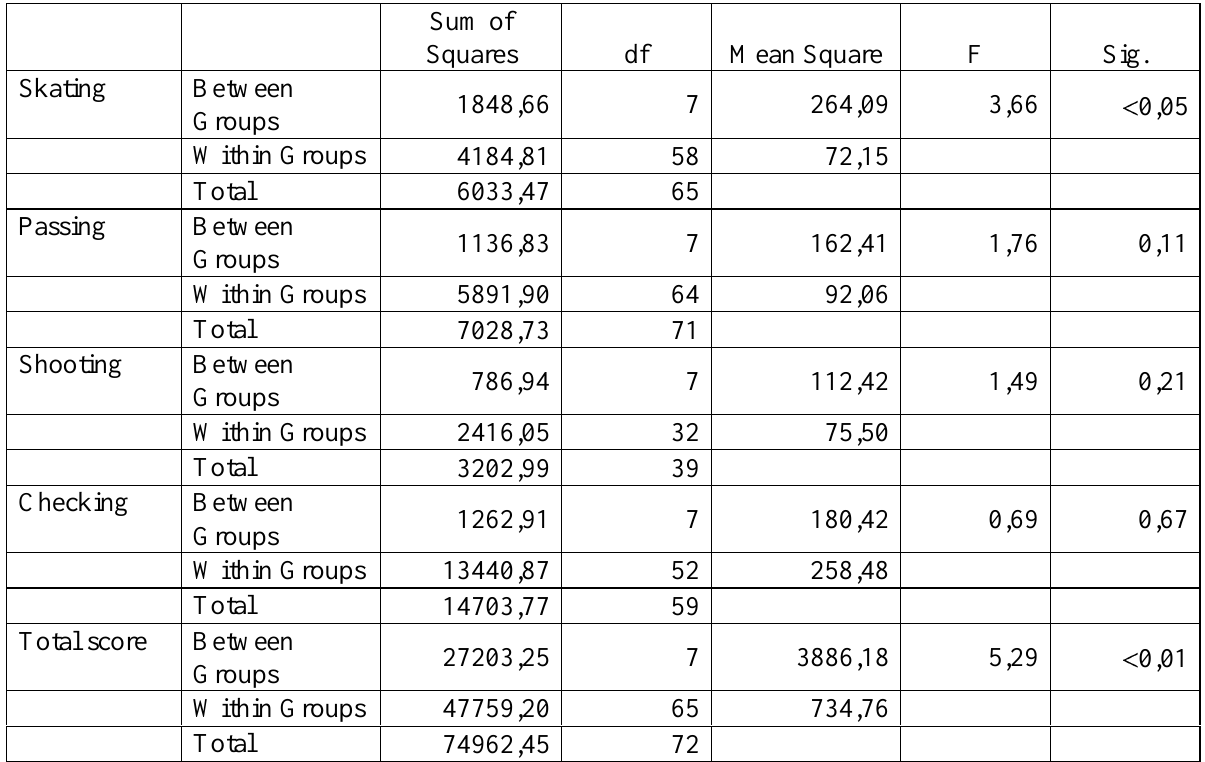
Results of ANOVA for mean scores of sledge hockey teams